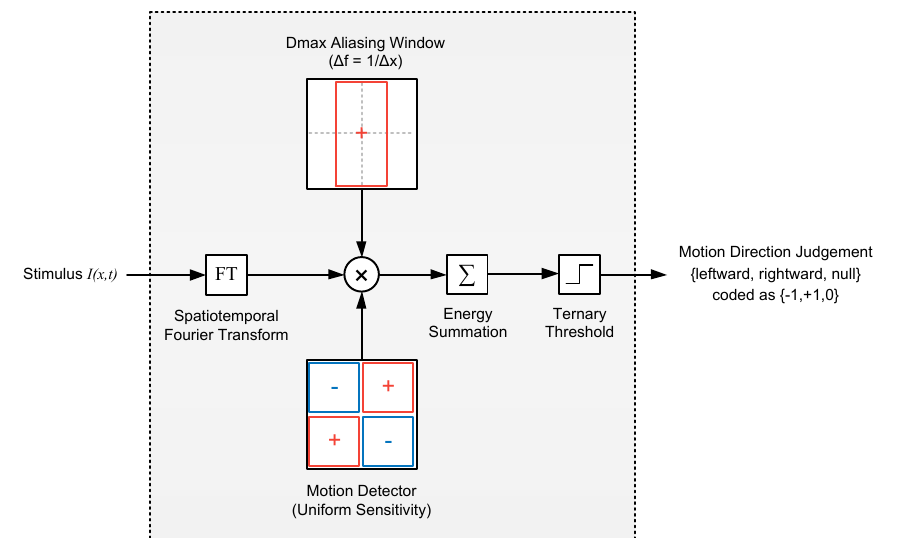
Figure 6. Apparent motion detection model based on Fourier Energy (Model 1). In this model, the spatiotemporal Fourier transform of the stimulus is filtered by a Dmax aliasing window (whose extent is ∆ f = 1/ ∆ x cpd, where ∆ x is presentation step size) and multiplied with the spatiotemporal sensitivity of an (ideal) motion detector. The net energy is then summed and passed through a ternary threshold to obtain a decision on the motion direction. The red and blue rectangles in filter blocks represent the spatiotemporal regions with positive and negative sensitivities,